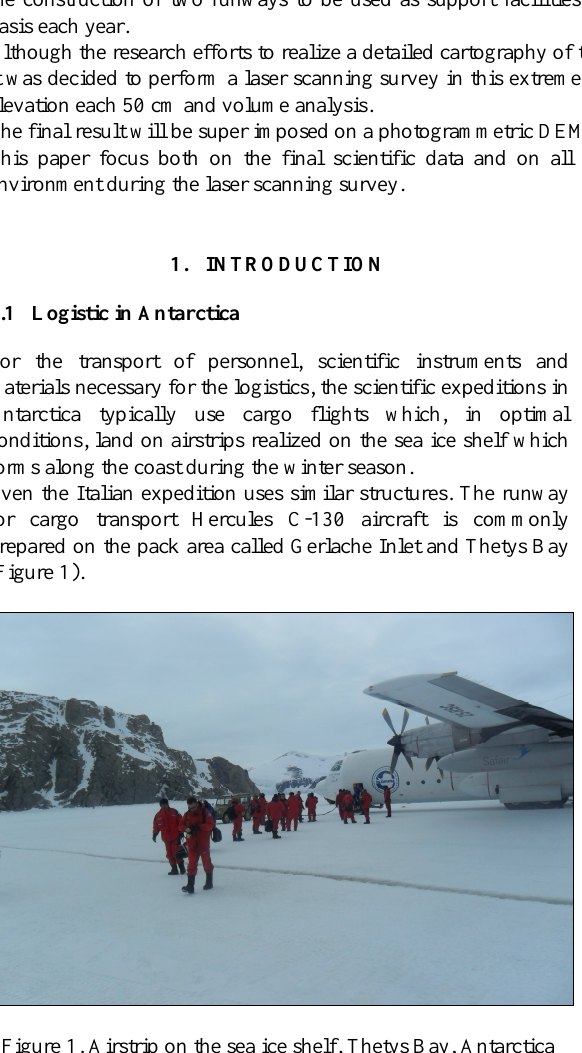
Figure 1. Airstrip on the sea ice shelf, Thetys Bay,